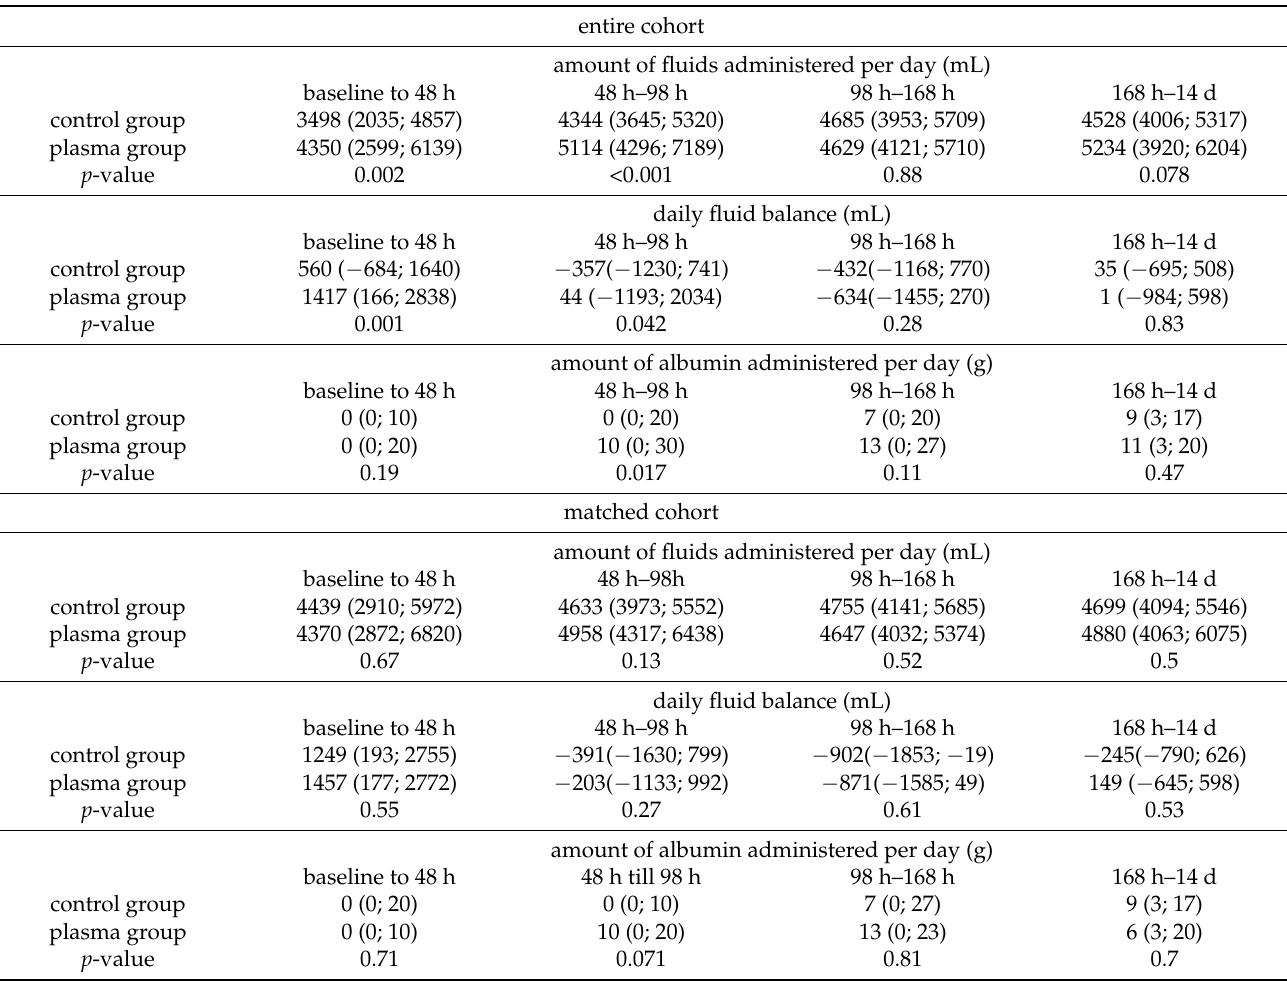
Table 2. Fluid balance and amount of fluids for the unmatched and matched cohort. Fluid balance and administered amount of fluids overall are given in milliliter (mL), albumin is reported in gram (g). Values are reported as median and interquartile range, comparison between groups was performed with the Mann Whitney U test. [h]: hours; [d]: